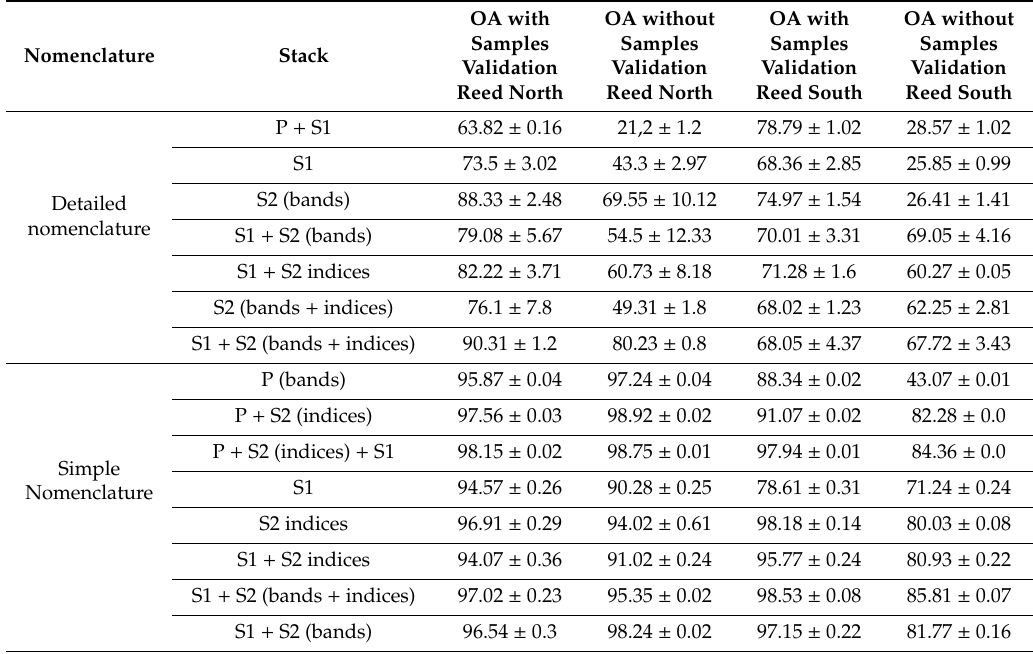
Table 3. The OA significant results for detailed nomenclature classifications + simple nomenclature classifications and standard